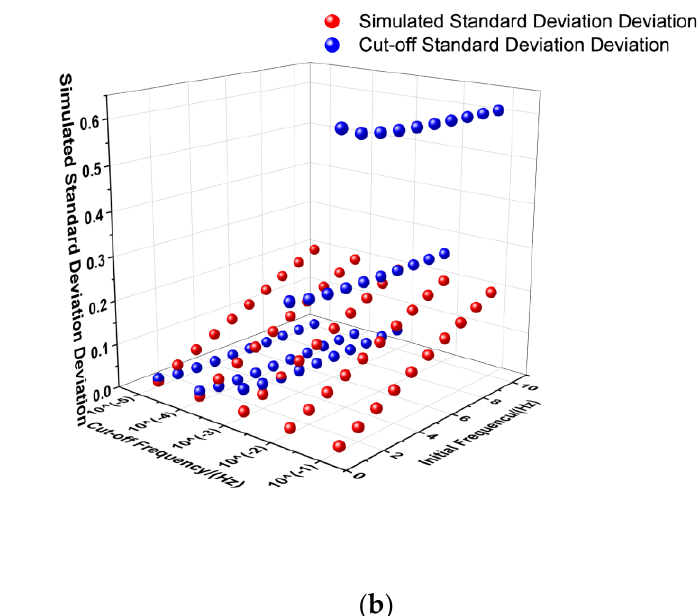
Figure 3. ( a ) The ratio of cut-off standard deviation and defined standard deviation along with the cut-off frequency change curve; ( b ) Standard deviation scatter distribution under different cut-off frequency intervals.